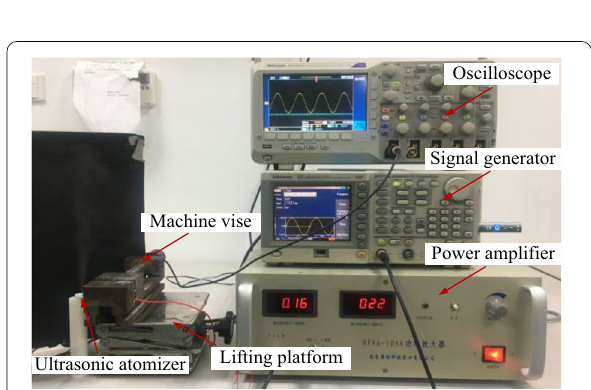
Figure 2 Photograph of the atomization experiment of the medical piezoelectric atomization device induced by intra-hole fluctuations